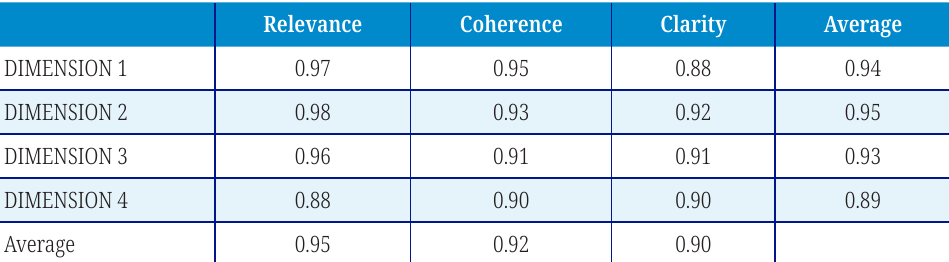
Table 2. Average by dimensions and criteria